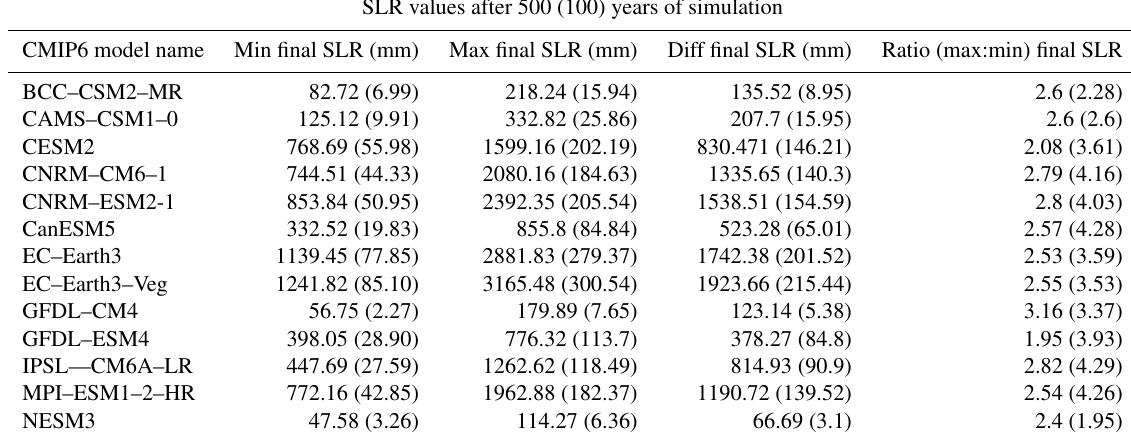
Table A1. SLR values after 500 (100) years of simulation for each climate model ensemble showing the minimum, the maximum, the difference and the ratio between the maximum and minimum. Brackets show values for 100 years after simulation